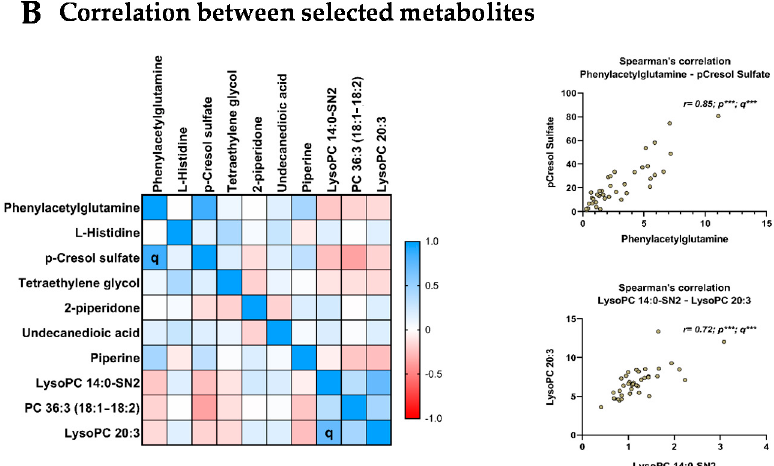
Figure 3. Relationship between the selected microbial genera and metabolites. ( A ) Spearman’s correlation matrix between genera of interest (TOP10). Significant (q < 0.05) correlation were high- lighted with “q”. Individual significant correlation were represented in the right part. ( B ) Spearman’s correlation matrix between metabolites of interest (TOP10). Significant (q < 0.05) correlation were highlighted with “q”. Individual significant correlation were represented in the right part. * p or q < 0.05;** p or q < 0.01:*** p or q < 0.001.